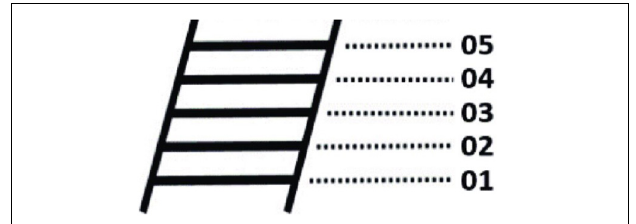
FIGURE 2 | The MacArthur Scale of Subjective Socioeconomic Status.